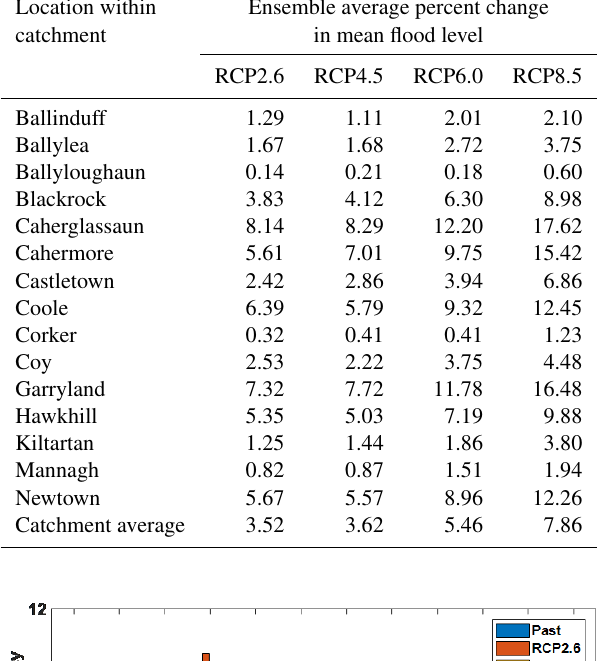
Table 3. Ensemble average percentage change in sample means for all RCM scenarios at all groundwater flood nodes within the South Galway karst model domain (a positive value indicates an increase in mean annual water level within the hydrological year).